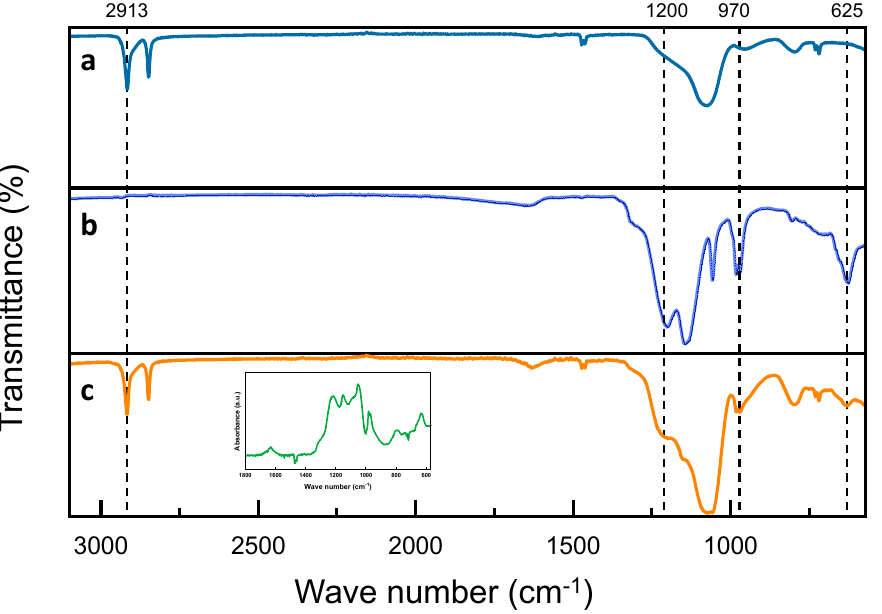
Figure 3. FT-IR of ( a ) Daramic; ( b ) Nafion; and ( c ) D-DMAc membranes—inset in ( c ): the difference Figure 3. FT ‐ IR of ( a ) Daramic; ( b ) Nafion; and ( c ) D ‐ DMAc membranes—inset in ( c ): the difference spectrum of D-DMAc membrane subtracting the Daramic spectrum of D ‐ DMAc membrane subtracting the Daramic curves.